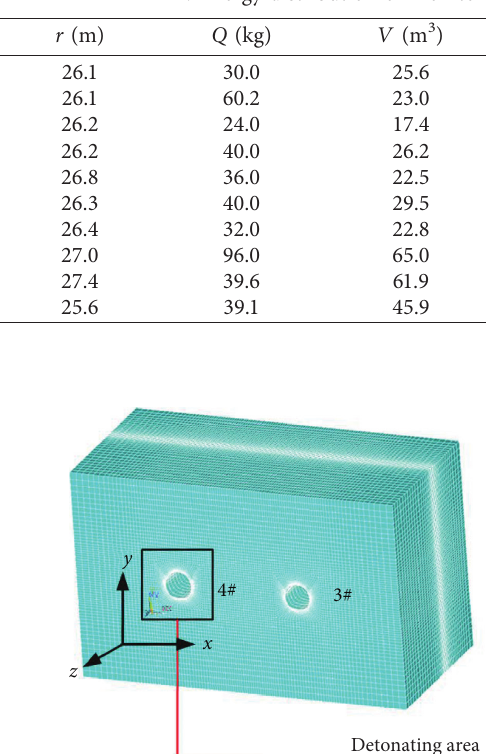
Table 1: Energy distribution of monitored vibrations and energy of calculation results.